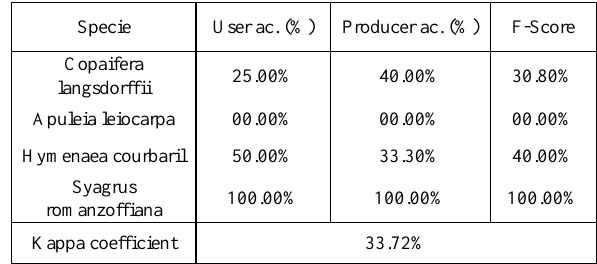
Table 7. Results of the validation set when RF model is applied in the region-based approach